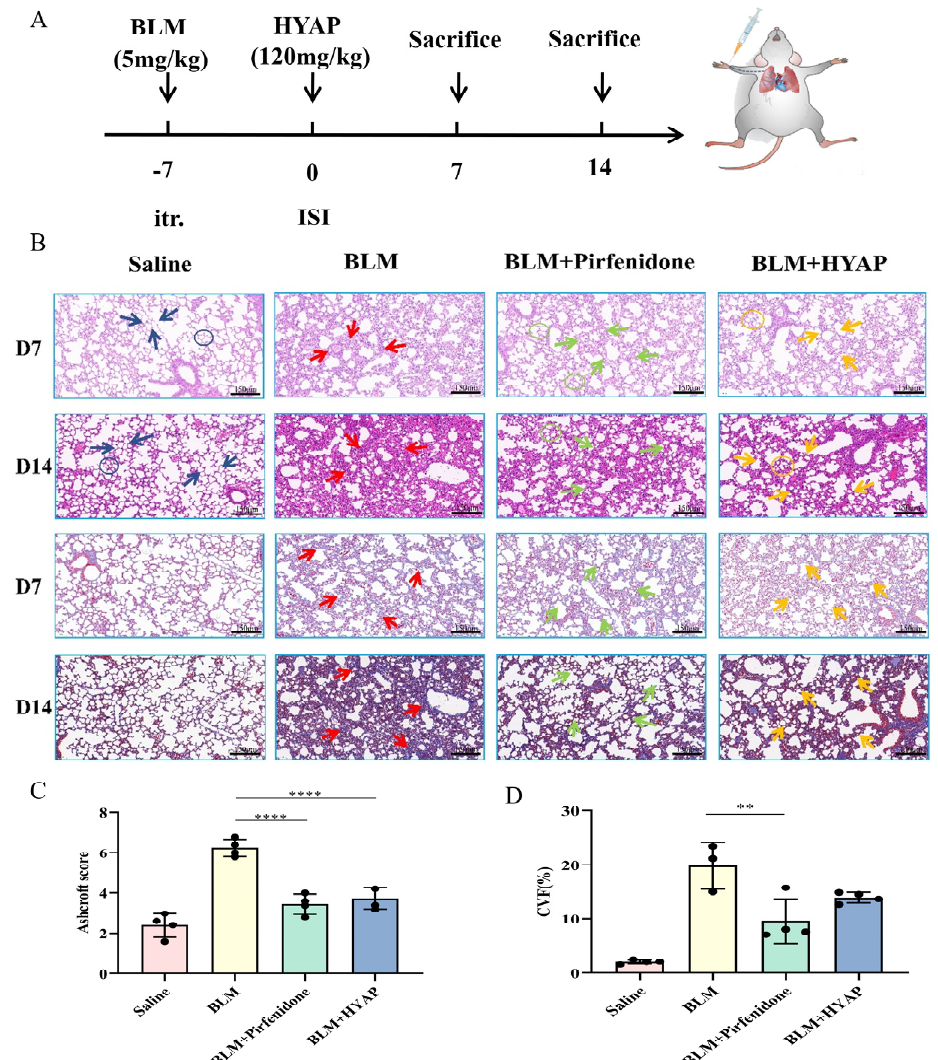
Figure 2. Histomorphological changes in the lungs of treated mice. ( A ) Schematic diagram of model establishment and treatment. ( B ) HE ( top ) and Masson trichrome staining ( bottom ) of lung tissue after different treatments ( n = 4). Blue arrows indicate the interval between normal pulmonary alveoli in the saline group, and blue circles indicate intact structure of pulmonary alveoli. Red arrows indicate the interalveolar septa in the BLM group that were significantly thickened, and blue collagen fibers were significantly more abundant. Green arrows indicate that the number of interalveolar septa reduced, and collagen deposition decreased in the BLM + pirfenidone group. The green circle indicates that the structure of pulmonary alveoli was restored. Yellow arrows indicate that the number of interalveolar septa was also significantly reduced in mice treated with HYAP, with a concomitant decrease in collagen deposition. Yellow circles indicate the intact structures of pulmonary alveoli. Scale bar: 150 µ m. ( C ) HE staining in different groups after 14 days of treatment was evaluated using the Ashcroft scoring method ( n = 4). The BLM group vs. the BLM + pirfenidone group, **** p < 0.0001, and the BLM group vs. the BLM + HYAP group, **** p < 0.0001. ( D ) The fraction of collagen volume of Masson trichrome staining after 14 days of treatment was calculated using Image J software ( n = 4). The BLM group vs. the BLM + pirfenidone group, ** p <